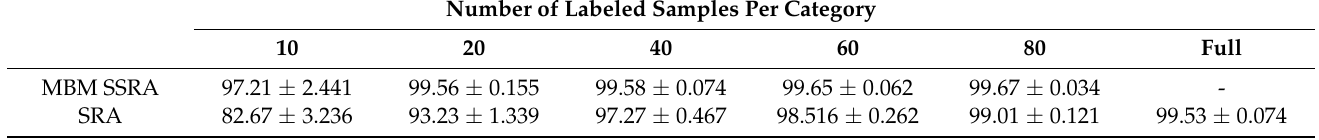
Table 2. Recognition accuracies of the proposed semi-supervised learning method and the corresponding supervised method under different amounts of labeled samples per category on the MSTAR data set. SSRA, semi-supervised recognition